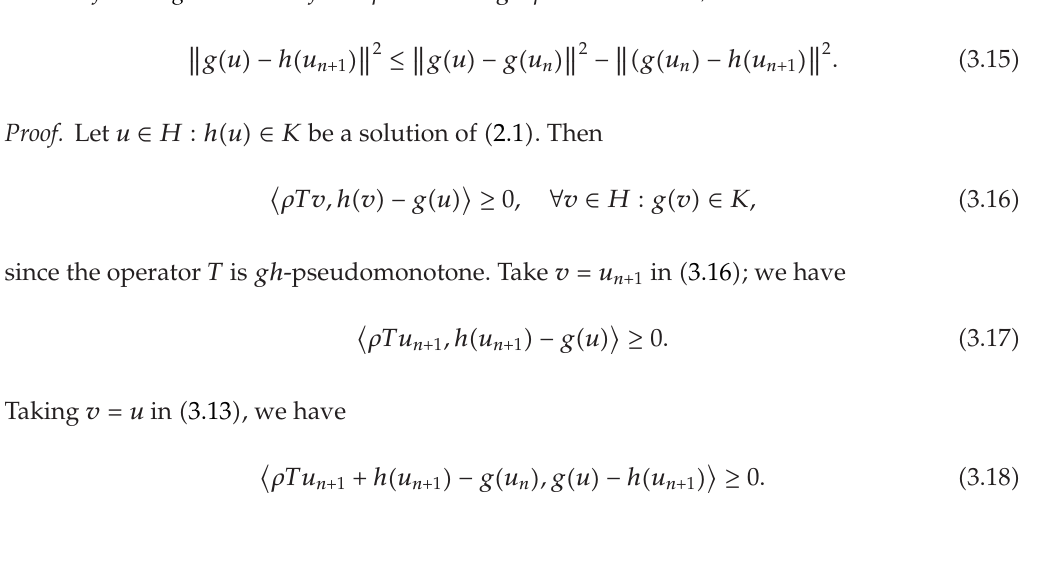
Algorithm 3.4. For a given u 0 ∈ H , find the approximate solution u n (cid:7) 1 by the iterative